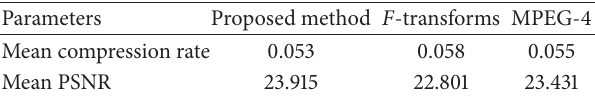
Table 1: Results for “tennis2” [6] in the proposed method. Parameters Y band U band V band Number of I-frames 15 Number of P-frames